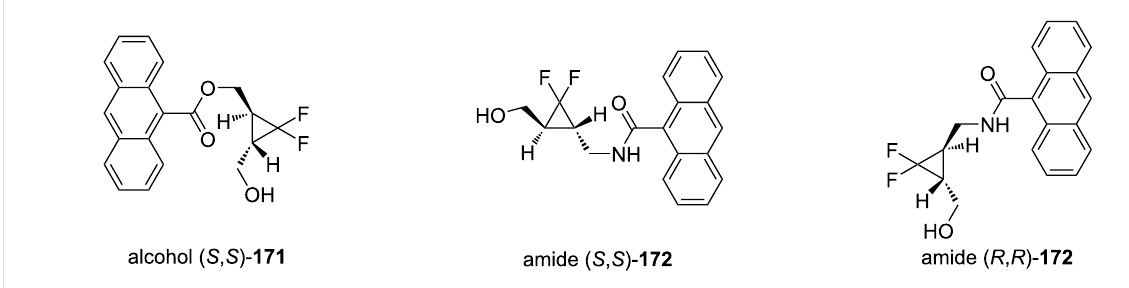
Figure 2: Anthracene-difluorocyclopropane hybrid derivatives.